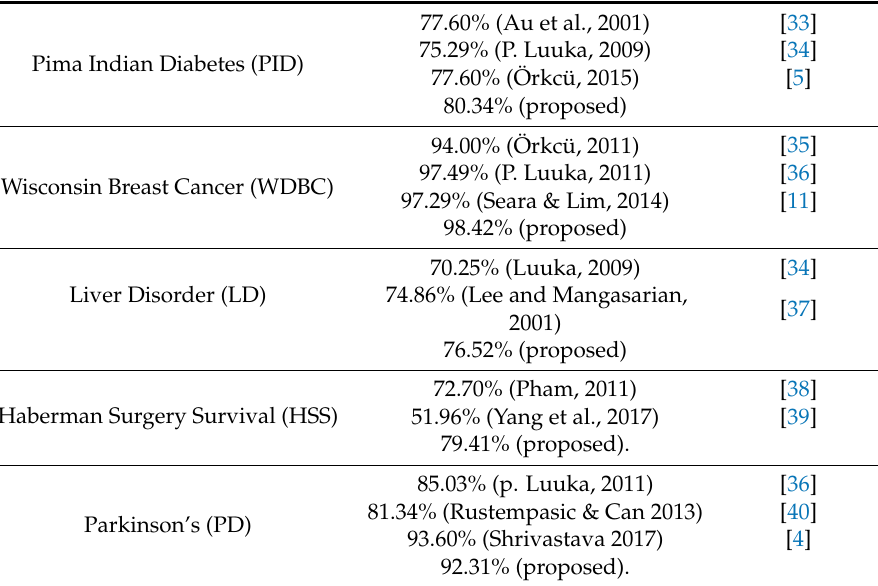
Table 10. Comparative